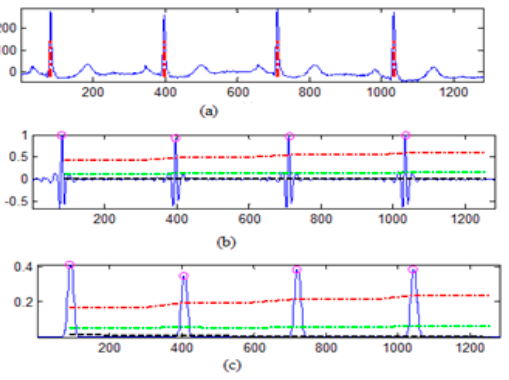
Figure 4. QRS detection ( a ) pulse train of the QRS on ECG signal ( b ) QRS on filtered signal ( c ) QRS on signal and noise level (black), signal level (red) and adaptive threshold (green). Sensors 2020 , 20 , x